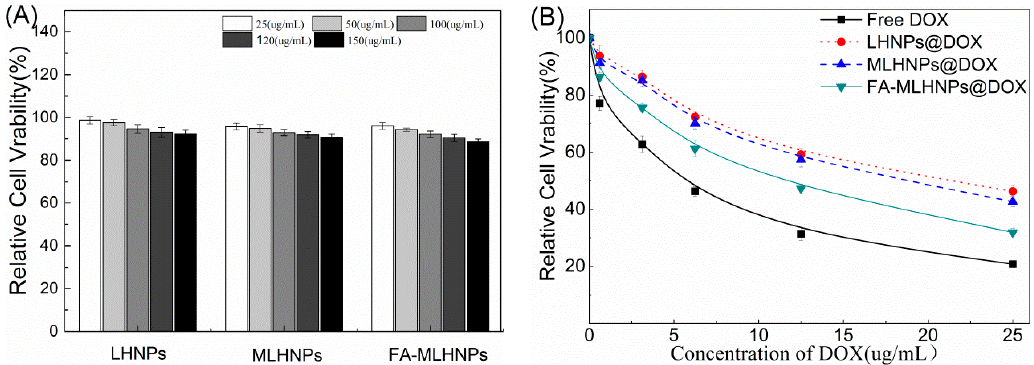
Figure 8. Viability of the HeLa cells after incubated with ( A ) LHNPs, MLHNPs and FA-MLHNPs